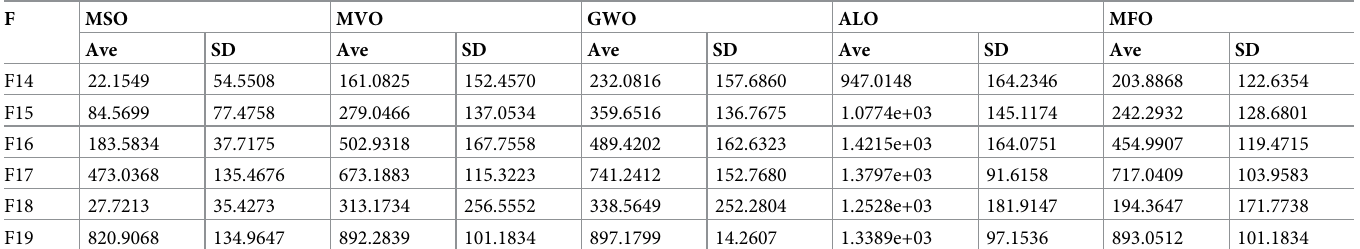
Table 6. Results of composite benchmark functions.